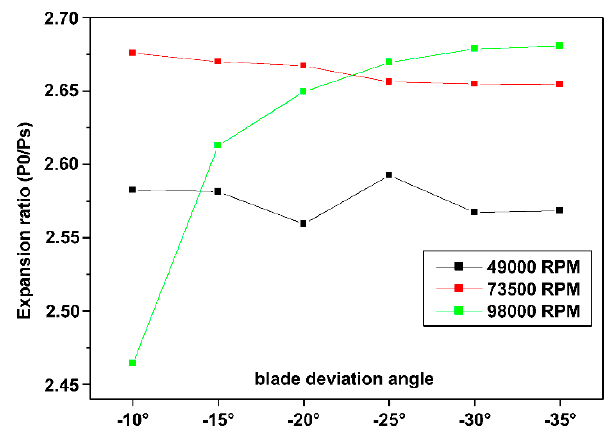
Figure 17. Expansion ratio for different deviation blade angles.